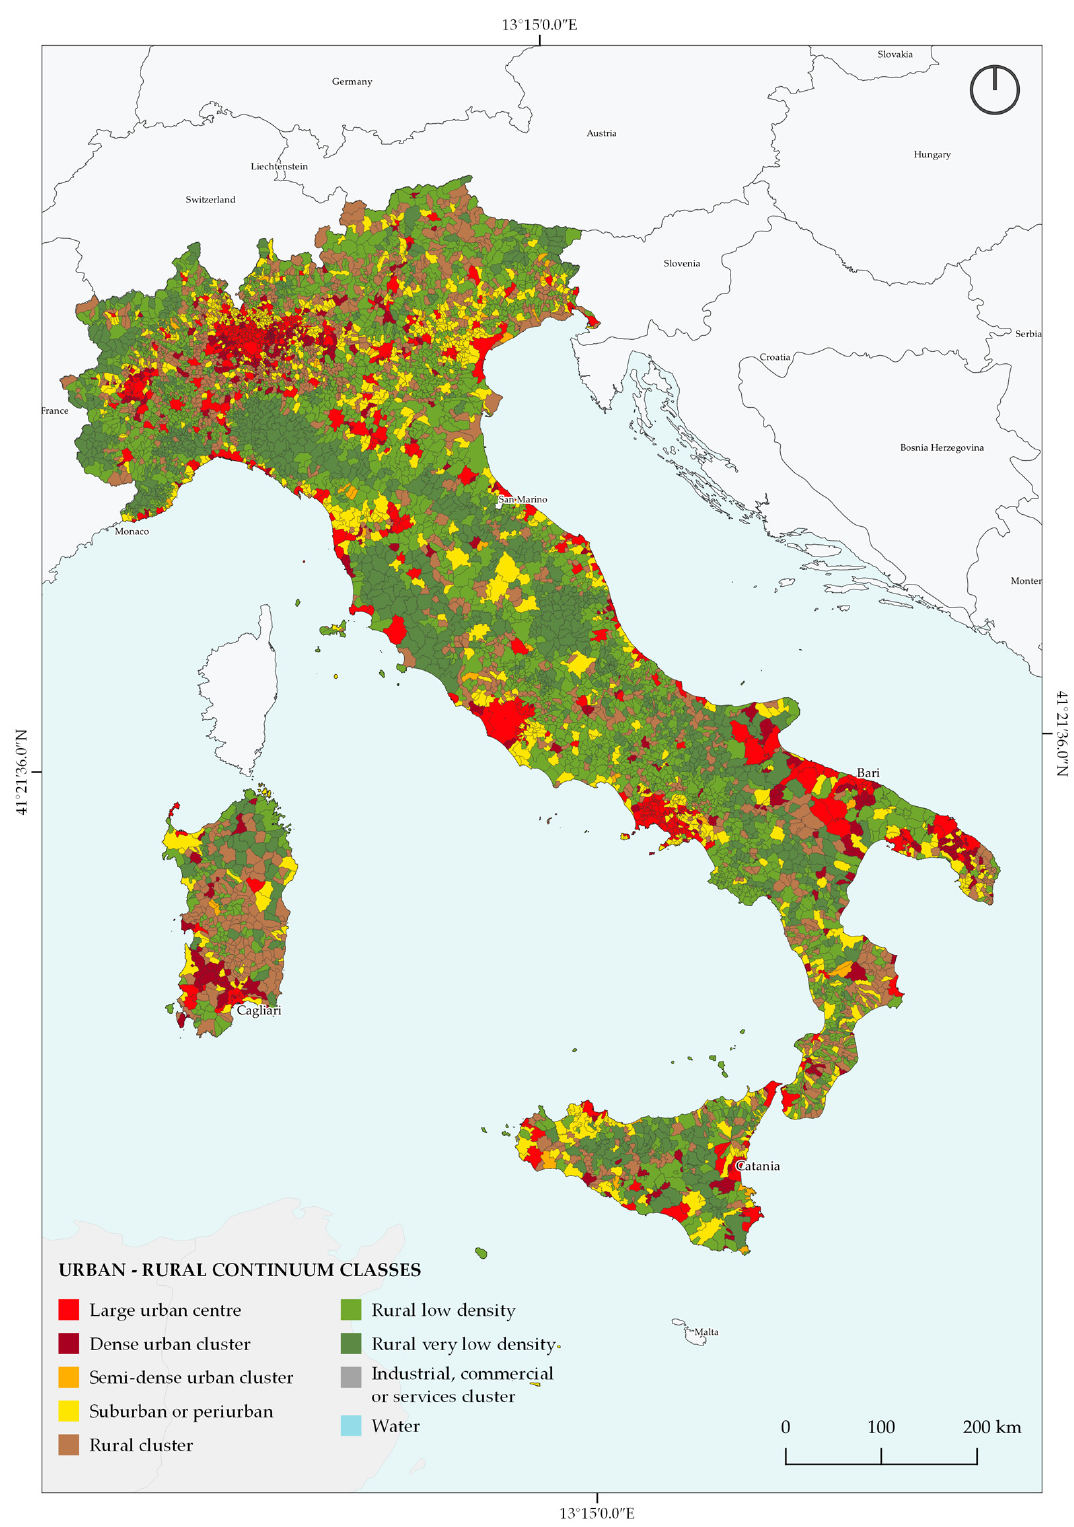
Figure 7. Urban–rural continuum classes in Italy (2018)—Attribution of the prevailing urban–rural class to the municipalities. Compared to Figure 5, this generalization leads to a loss of detail, which limits intra-municipal analyses, but still allows evaluations and comparisons to be made between different municipalities attributable to the same classes.